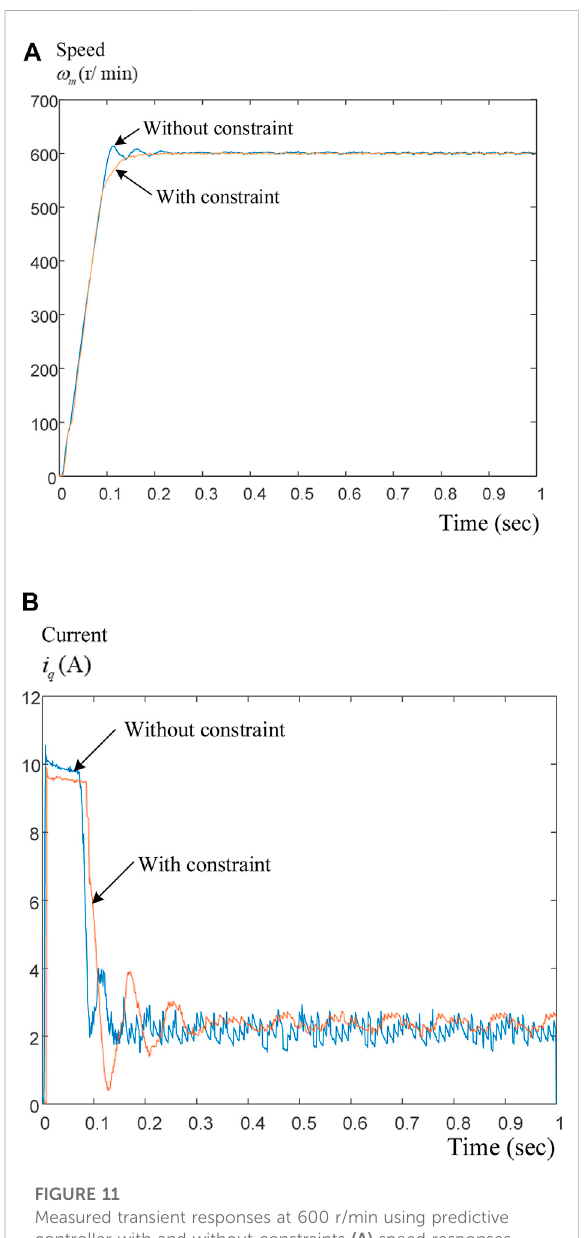
FIGURE 11 Measured transient responses at 600 r/min using predictive controller with and without constraints (A) speed responses (B) q-axis current responses.